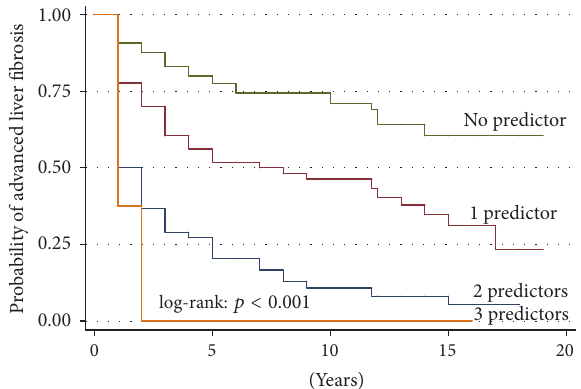
Figure 3: Survival curves of probability of advanced liver fibrosis development according to the number of predictors among chronic HCV infection, hypoalbuminemia, and